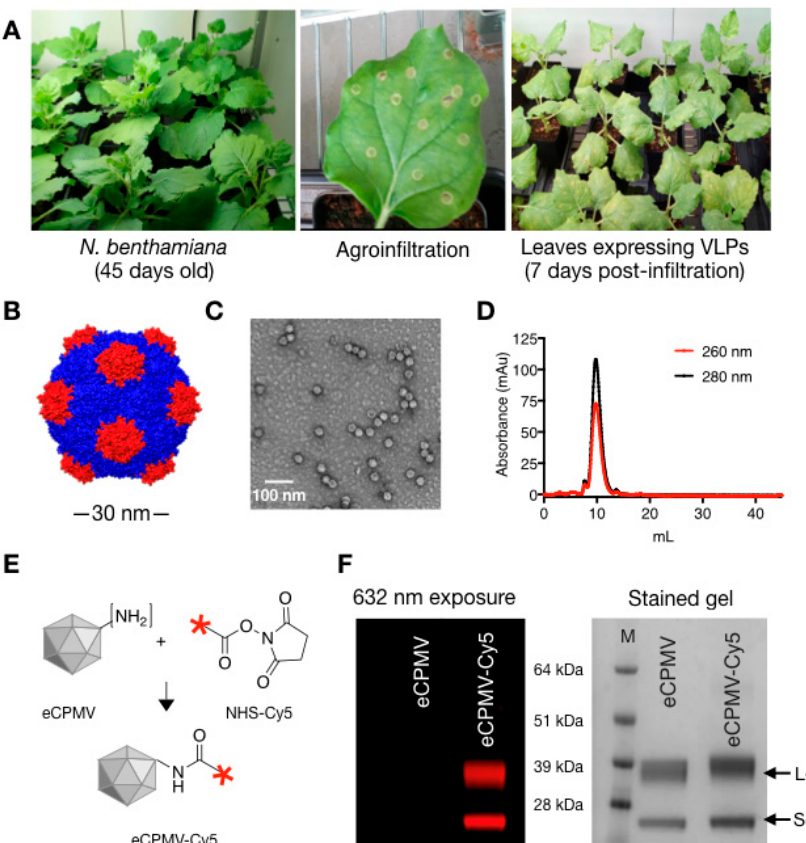
Figure 1. eCPMV propagation, purification and characterization. ( A ) eCPMV VLPs were propagated using N. benthamiana plants; leaves were infiltrated when plants were 45 days old. ( B ) Structure of eCPMV, chimera image created using PDB file 1NY7 (CPMV) ( C , D ) Purified eCPMV particles were characterized for structural integrity using TEM and size exclusion chromatography